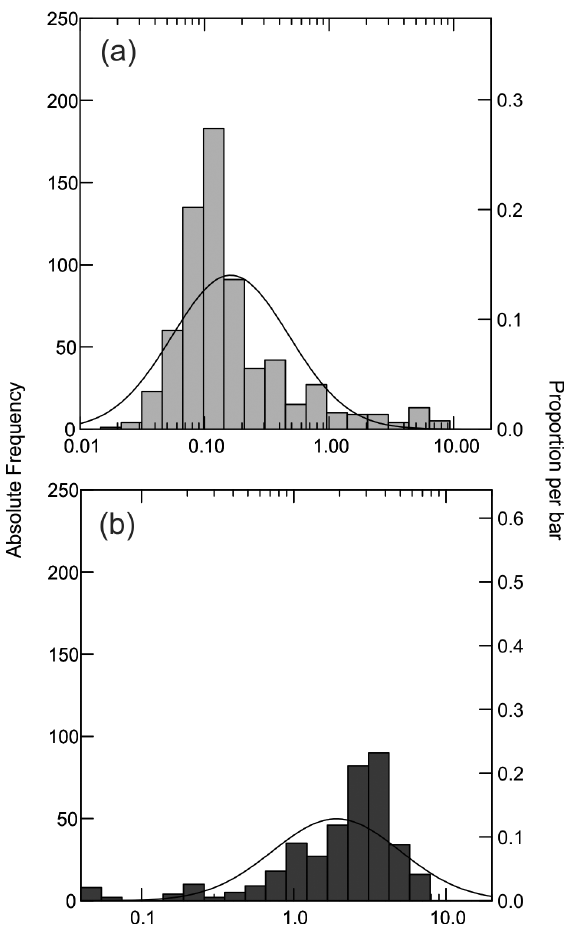
Figure 8 - Histograms (absolute frequency) showing the magnetic susceptibility (MS) variation for representative samples of the Papanduva (a) and Quiriri (b)